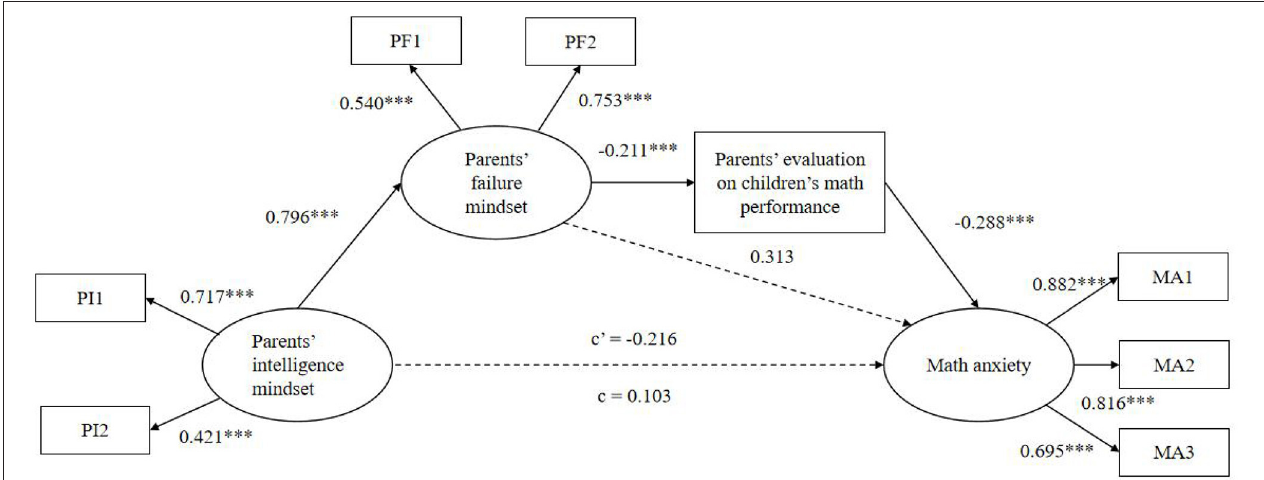
FIGURE 2 | Full model; *** p < 0.001.